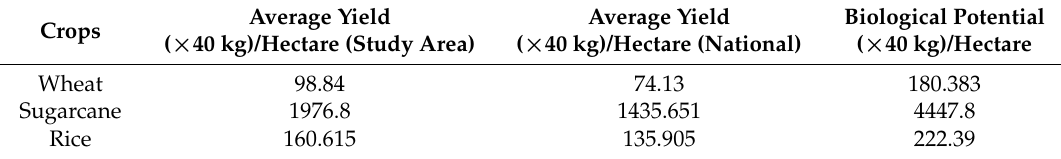
Table 1. Comparison between average yield in the study area with national average and biological yield potential.